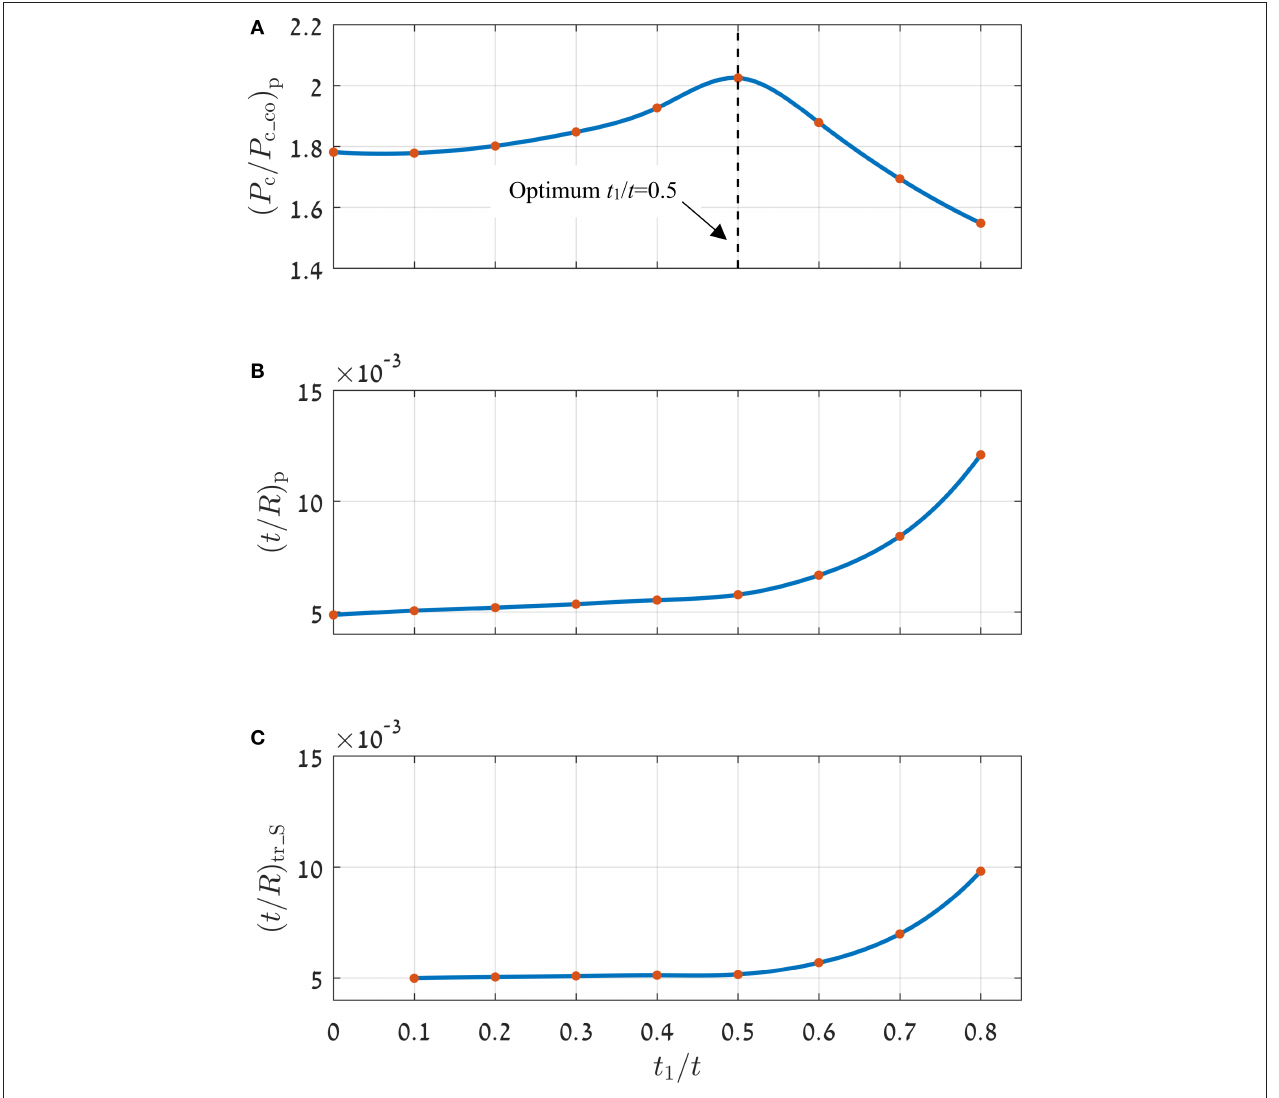
FIGURE 5 | Peak dimensionless critical load, ( P c / P c_co ) p (A) , dimensionless coating thickness at peak critical load, ( t / R ) p (B) , and dimensionless transition coating thickness, ( t / R ) tr_S (C) , for different middle-layer dimensionless thickness, t 1 / t . Material properties as in Table 1 .